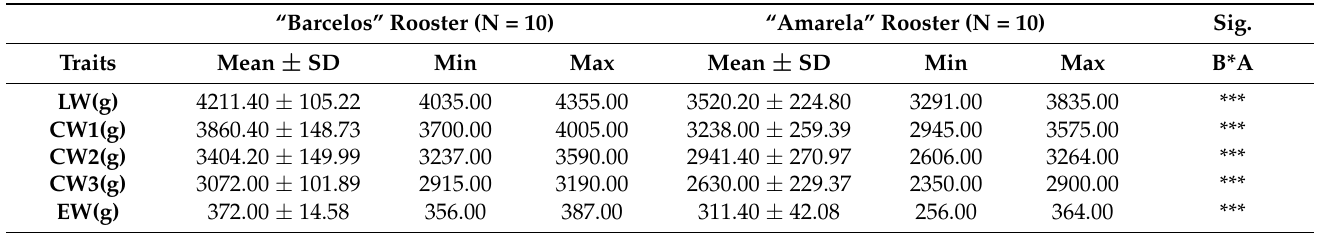
Table 1. The carcass characteristics of the “Barcelos” and “Amarela” roosters (average ± SD, Min and Max). “Barcelos” Rooster (N = 10) “Amarela” Rooster (N = 10) Sig.